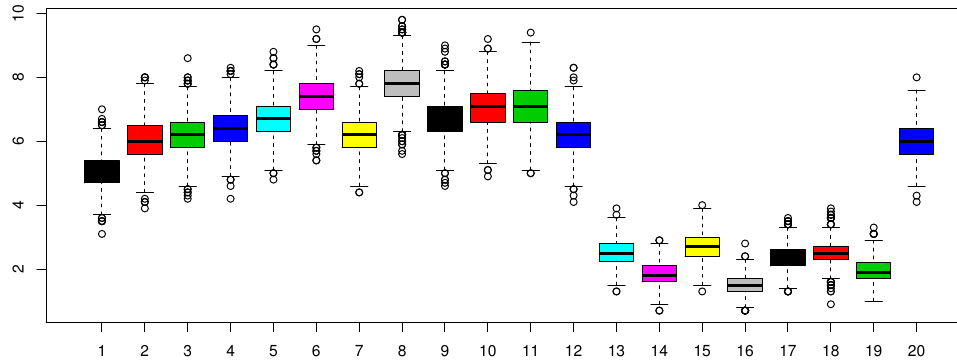
Figure 8. Campania, bootstrapped observations referring to 2015. Distribution of the number of meteorological stations in each of the 20 temperature